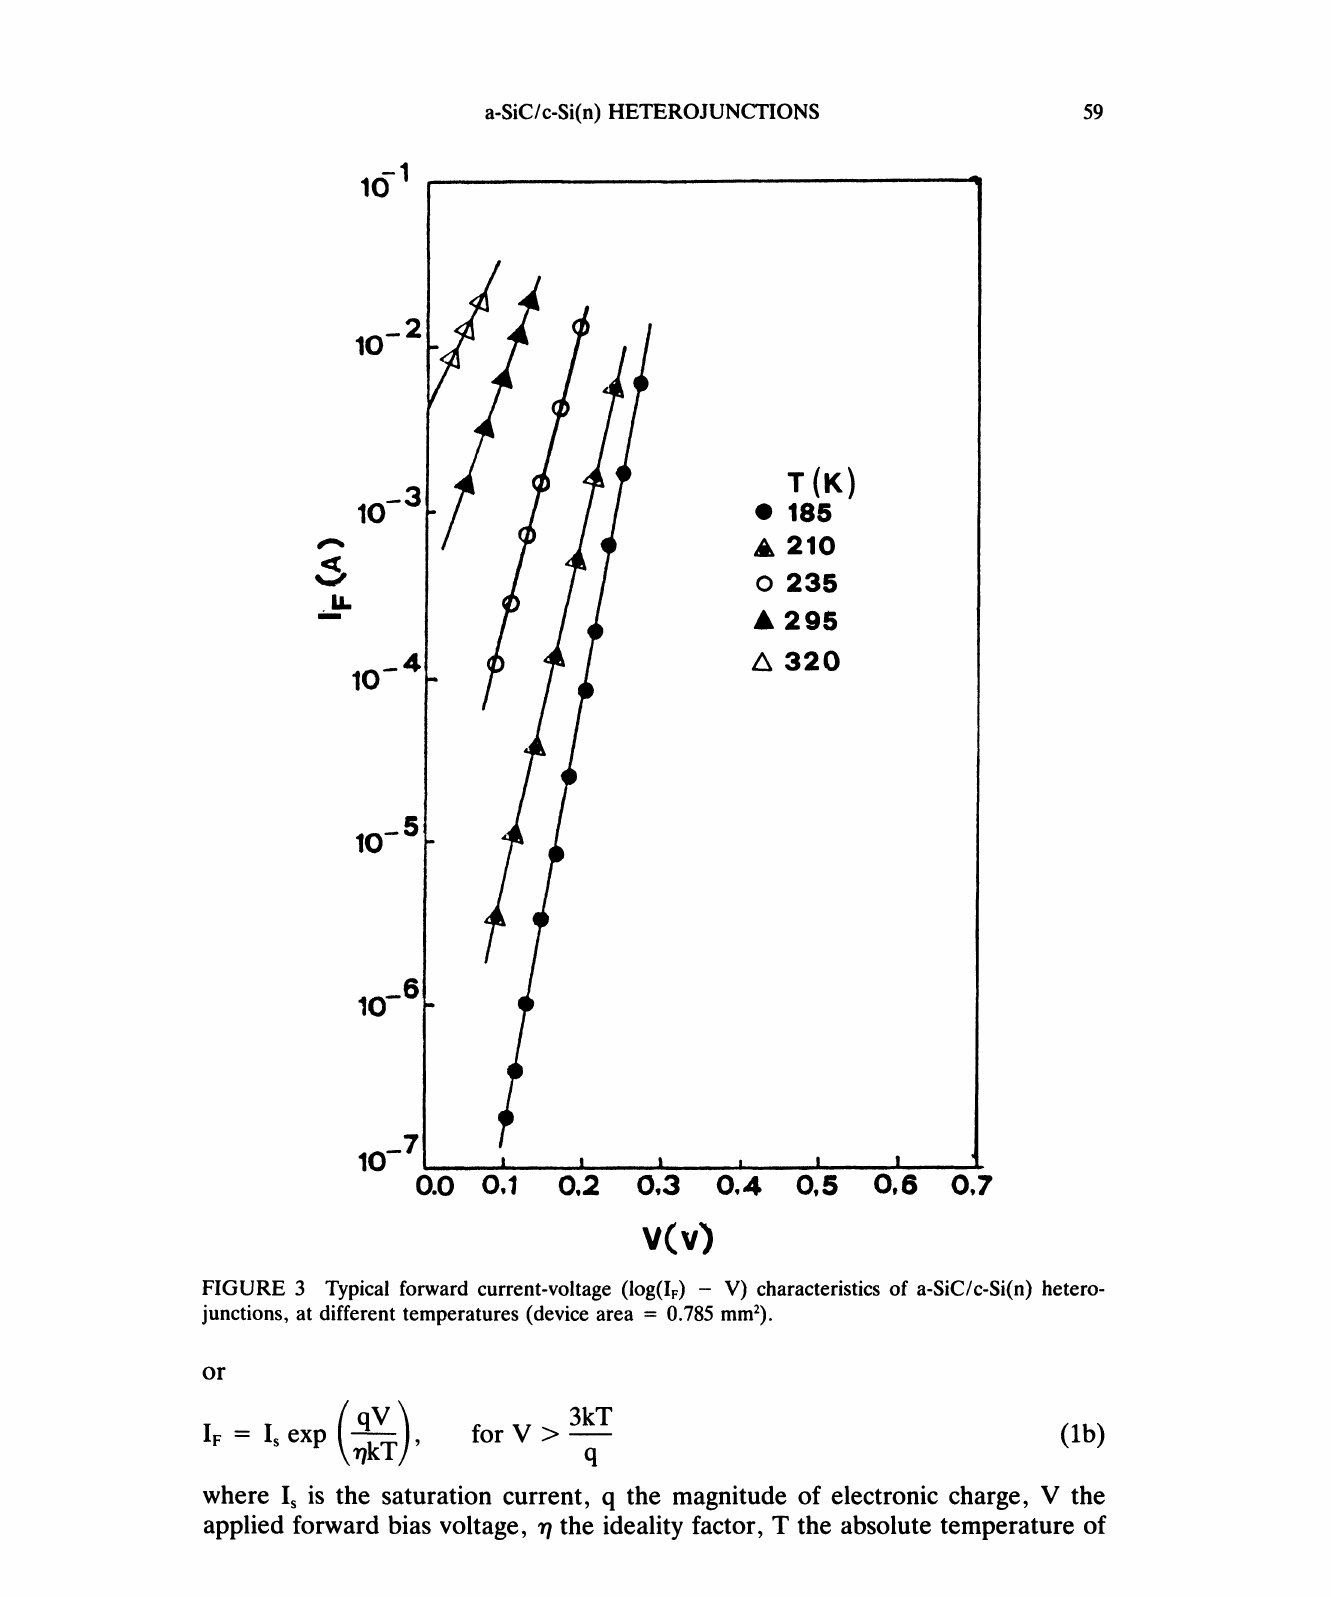
FIGURE 3 Typical forward current-voltage (log(IF) V) characteristics of a-SiC/c-Si(n) hetero- junctions, at different temperatures (device area 0.785 mm2).